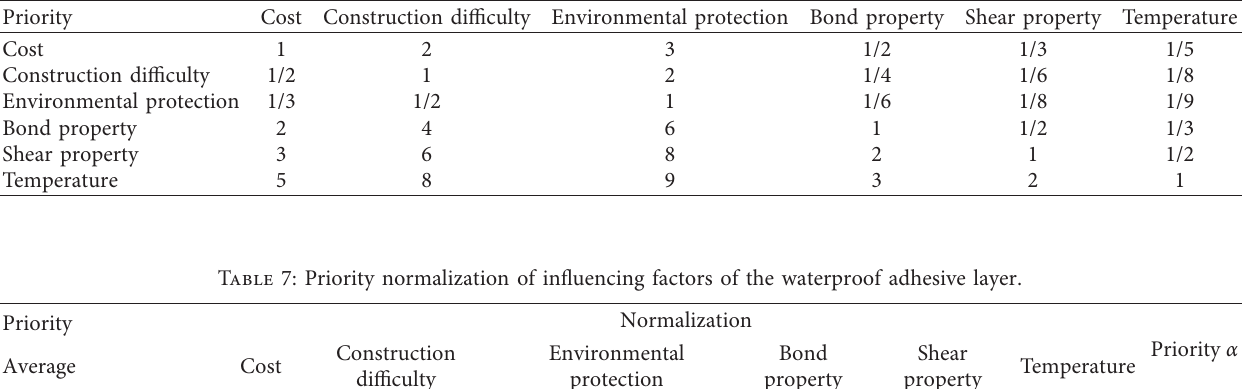
Table 6: Priority determination of influencing factors of the waterproof adhesive layer.